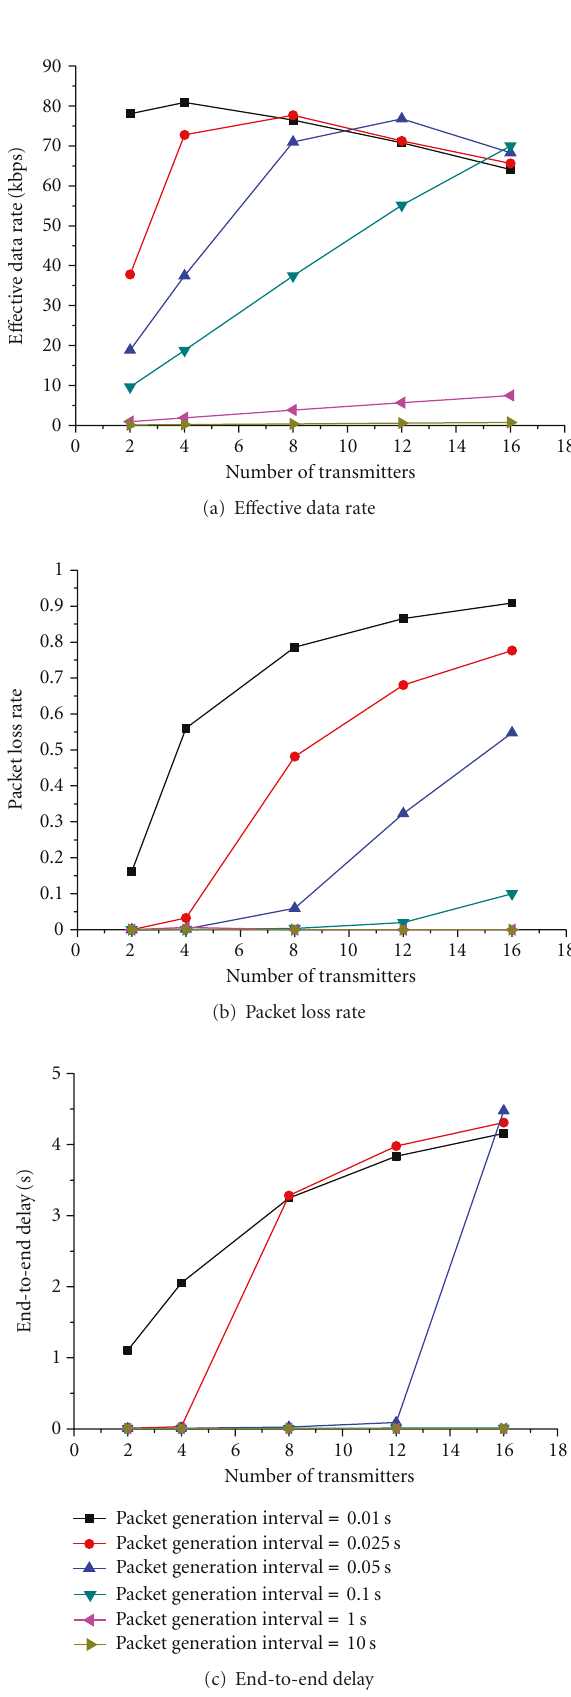
Figure 3: QoS with di ff erent MSDU sizes. Figure 4: QoS with di ff erent packet generation